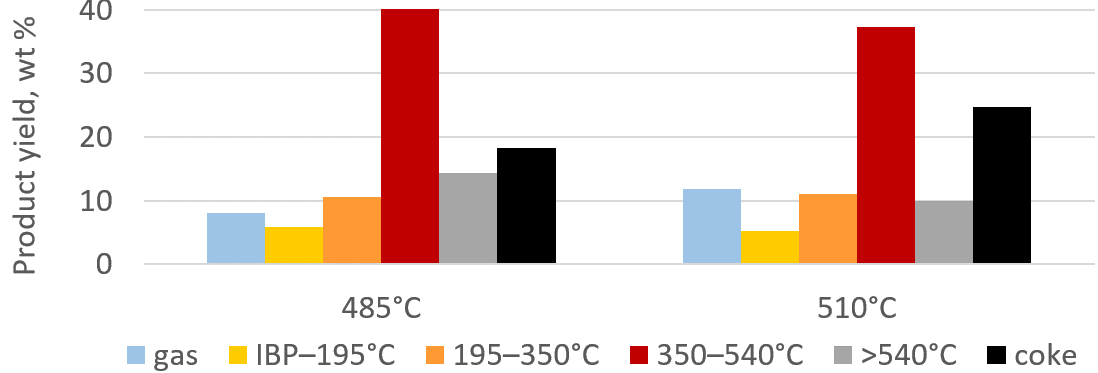
Figure 2. Products yield of the adsorptive treatment of VisR/LCG (70/30%).